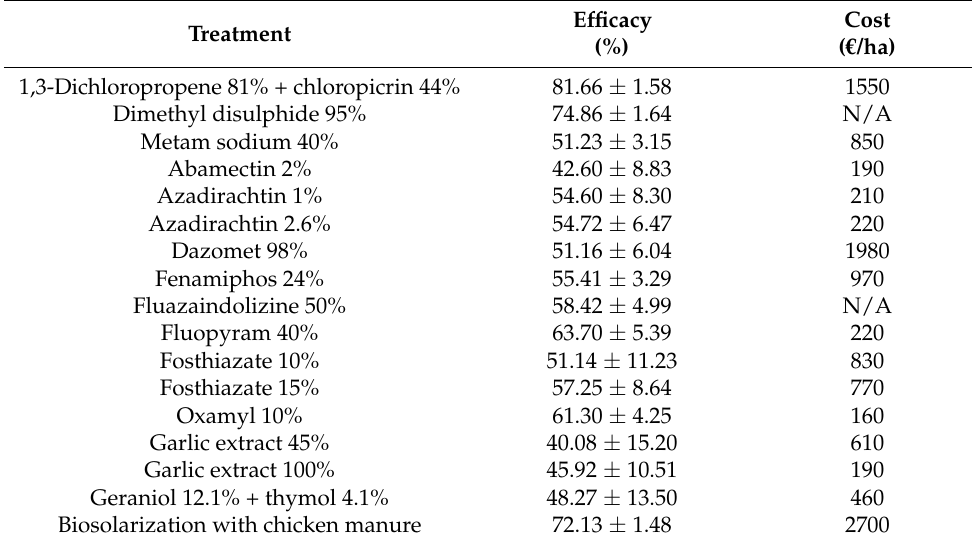
Table 1. Nematicidal efficacies and costs of nematode management treatments.